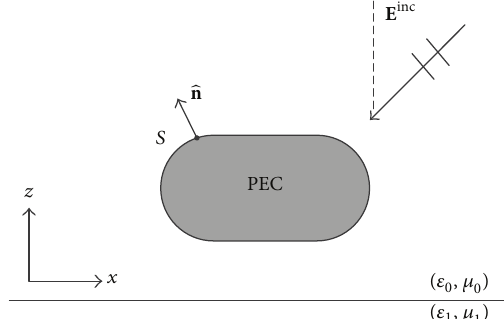
Figure 1: The geometry of a 3D PEC object above the half